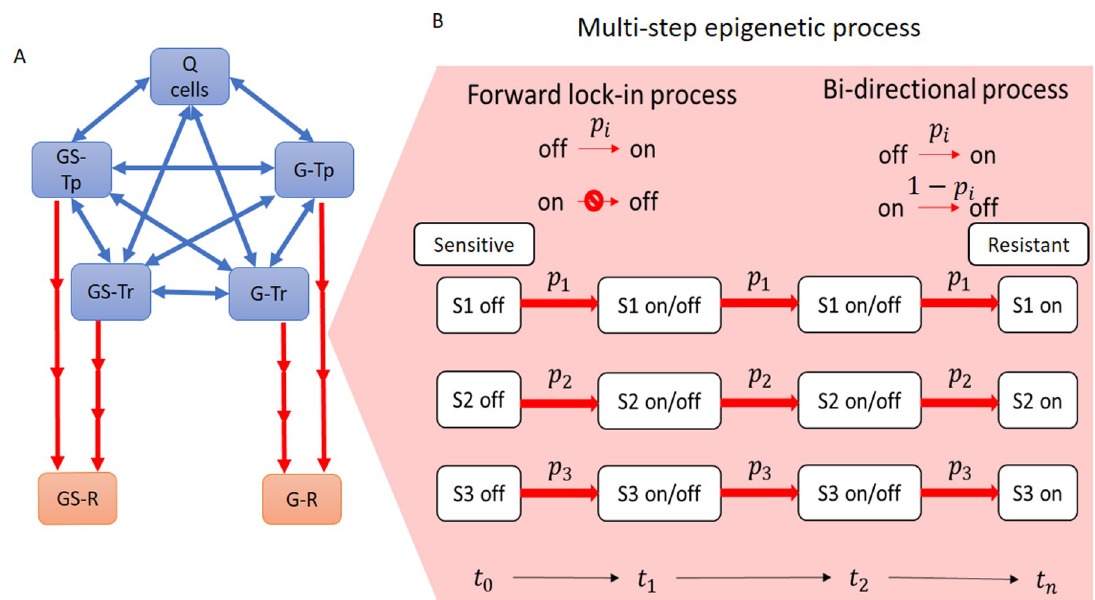
Fig 3. Schematic of the multi-Step model. (A) The multi-step model requires transitions to drug-resistant states to be a multi-step process (red arrows). Single-step processes are shown as blue-arrows. (B) The three-step transition model is shown between sensitive and resistant cell states. The forward lock-in process requires all three switches (S1, S2 and S3) to be on, whereas the bidirectional process allows any of the three switches to go from on ➔ off, thus, interrupting a transition to a resistant state. p i indicates the probability of the event occurrence (switch turning off ➔ on or on ➔